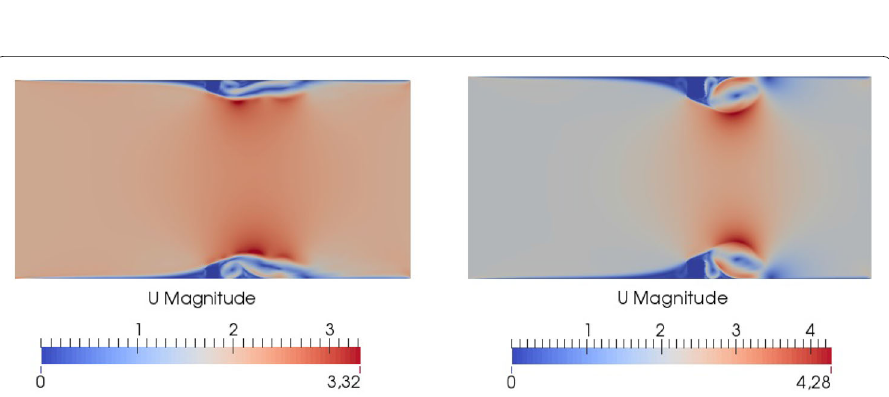
Fig. 2 On the left, the level set function with an obstacle on the upper and lower walls. On the right, the level set function with a new obstacle translated with respect to the first one in the horizontal direction, and with a new length